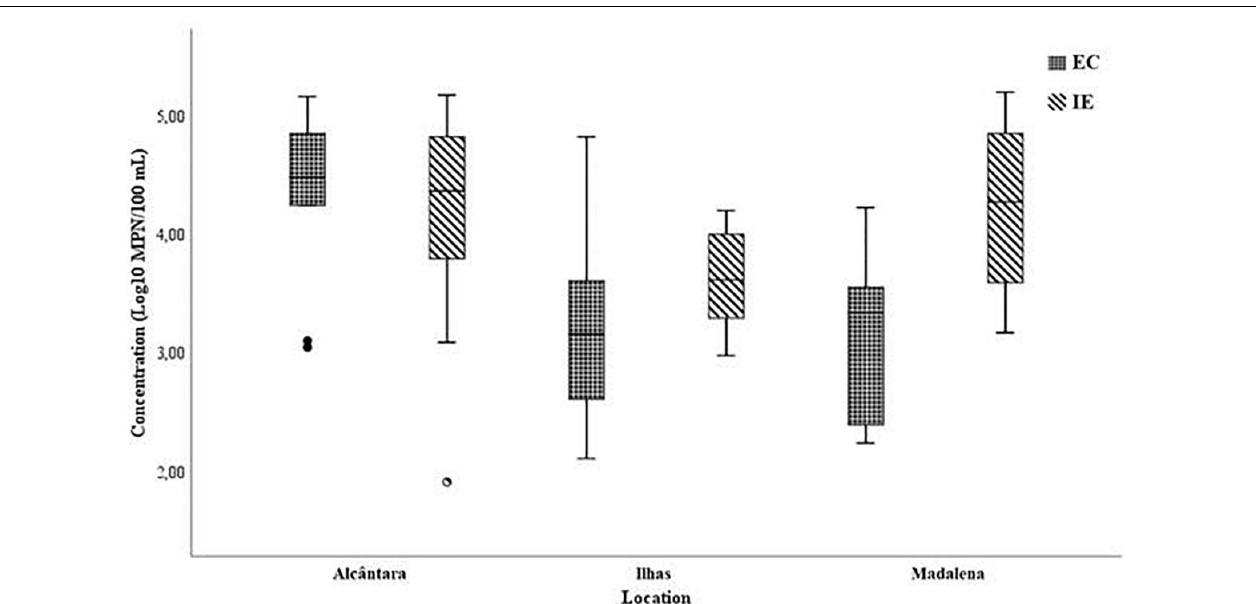
FIGURE 2 | Concentration of EC (A) and IE (B) in the three locations chosen, Boxes, 25th and 75th percentile; Whiskers, 10th and 90th percentile; inside the boxes, median.